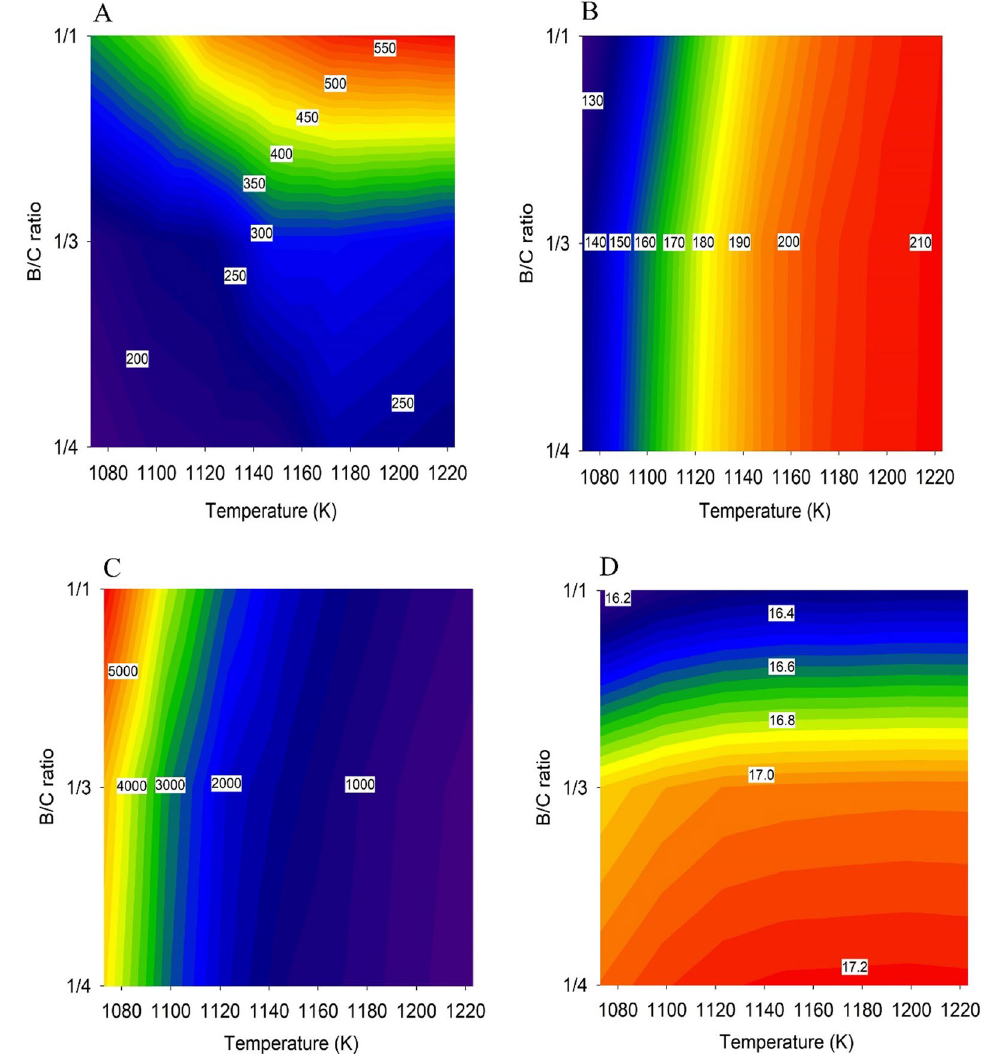
Fig. 3 Effect of operating temperature on a NO, b SO 2 , c CO and d CO 2 composition at total feed of 4 kg/h and air flow rate of 25 kg/h with dif- ferent Biomass/Coal (B/C)